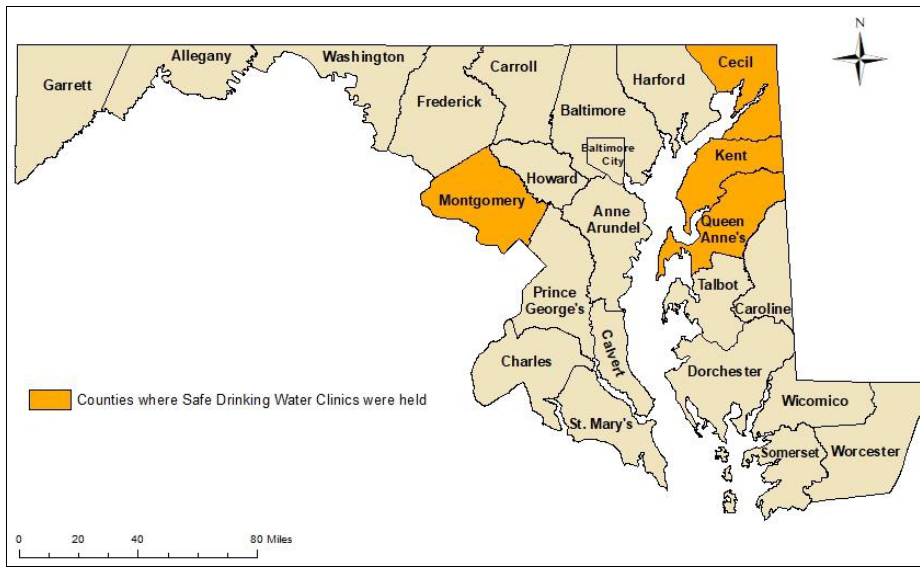
Figure 1. Maryland counties where safe drinking water clinics were held. Table 1. Dates on which the safe drinking water clinics were held.